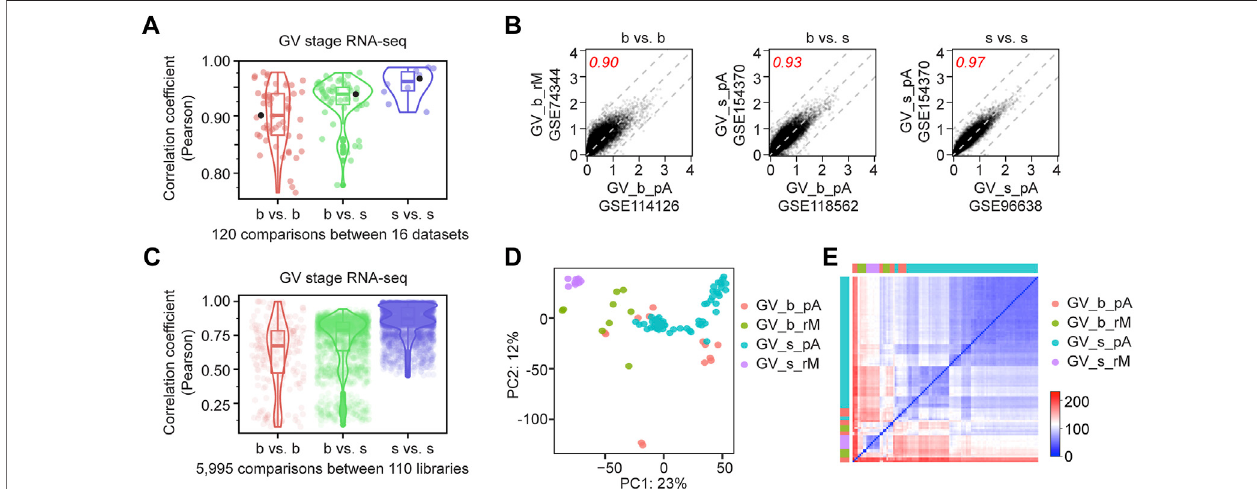
FIGURE 1 | Single oocyte RNA-seq has high reproducibility. (A) Dot plots showing the Pearson correlation coef fi cients between 120 pair-wise comparisons of 16RNA-seqdatasetsofmousegerminalvesicle(GV)oocytes.Dotsaregroupedbybvs.b(bulkvs.bulk),bvs.s(bulkvs.single)andsvs.s(singlevs.single).Boxesand violins indicate the distribution of the dots. The three highlighted black dots are shown in (B) . (B) Examples from each comparison group in (A) , showing transcript abundanceregressionanalysisbetweentwodatasets. Valuesrepresent thelog 10 meanofgenecountsfromalllibrariesineachdatasetnormalized bylibrarysizes. Three gray dashed lines: y = x, y = x + 1 and y = x − 1. Red numbers are the Pearson correlation coef fi cients. (C) Dot plots showing the Pearson correlation coef fi cients between 5,995 pair-wise comparisons of 110 individual libraries. Dots are grouped by b vs. b (bulk vs. bulk), b vs. s (bulk vs. single) and s vs. s (single vs. single). Boxes and violinsindicatethedistribution ofthedots. (D) Principalcomponentanalysisofall110librariesfrom16datasets atGVstage,b:bulk,s:single,pA: poly(A)RNA-seq, rM: RiboMinus RNA-seq. Details of dataset information are in Supplementary Table S11 . (E) Sample distance matrix of all 110 libraries from 16 datasets at GV stage.